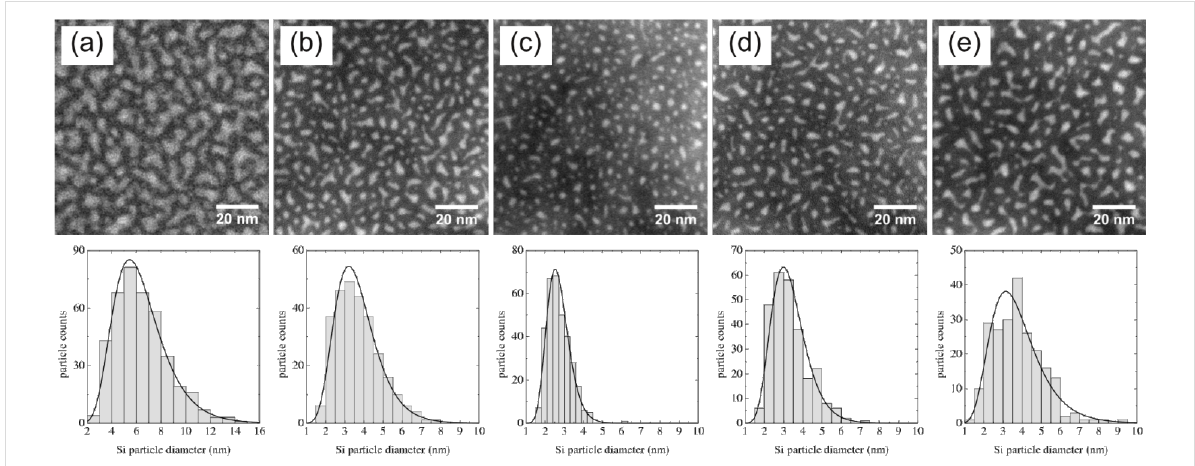
Figure 4: EFTEM images and corresponding Si NC size distributions of S5-S9: (a) S5 (10 nm SiO 0.93 ), (b) S6 (4.5 nm SiO 0.93 ), (c) S7 (3.5 nm SiO 0.93 ), (d) S8 (3.5 nm SiO 0.85 ), (e) S9 (3.5 nm SiO 0.64 ).